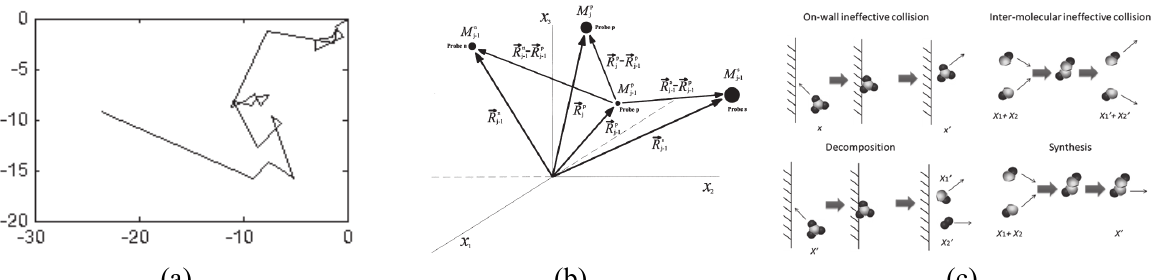
Fig. 1. The representation of search methods of representing algorithms (a) Levy fl ight distribution in CS (b) multi-dimensional search in CFO (c) four chemical reactions types in